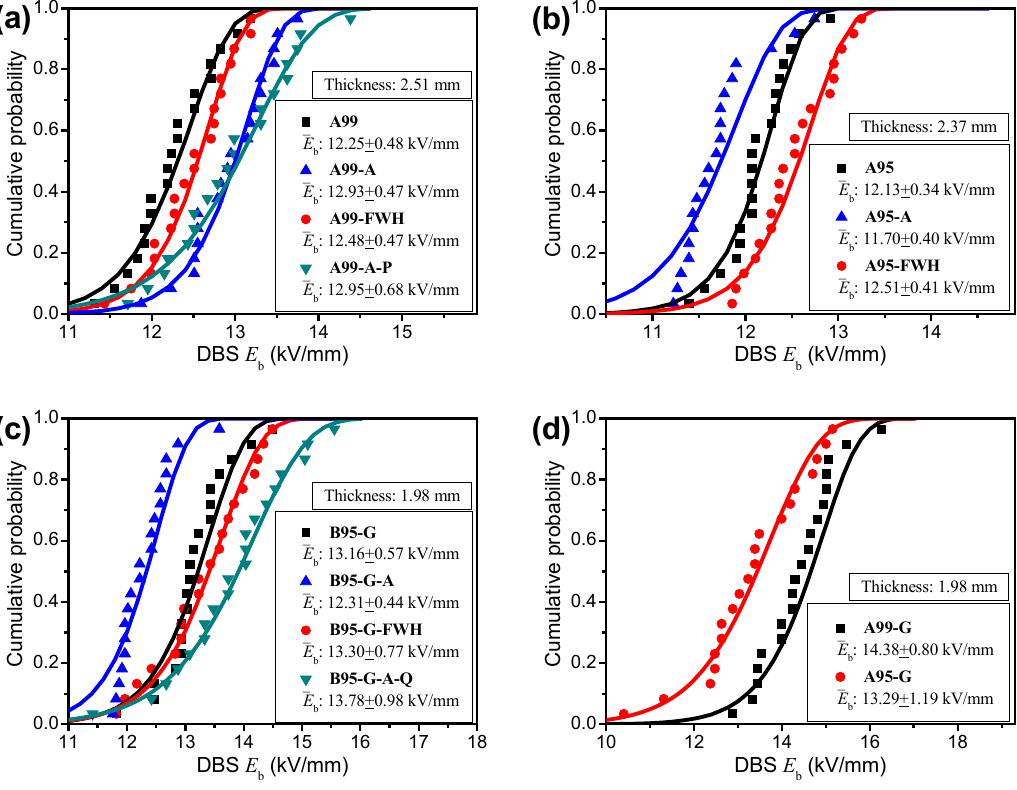
Fig. 2 Measured DBS E b data sorted in ascending order and the Weibull distribution fitting (lines): the cumulative probability corresponding to the i- th value sorted in ascending order is equal to ( i – 0.3)/( n + 0.4), where n is the total number of the values. The inset data E ¯ b is the average value of E b with the standard